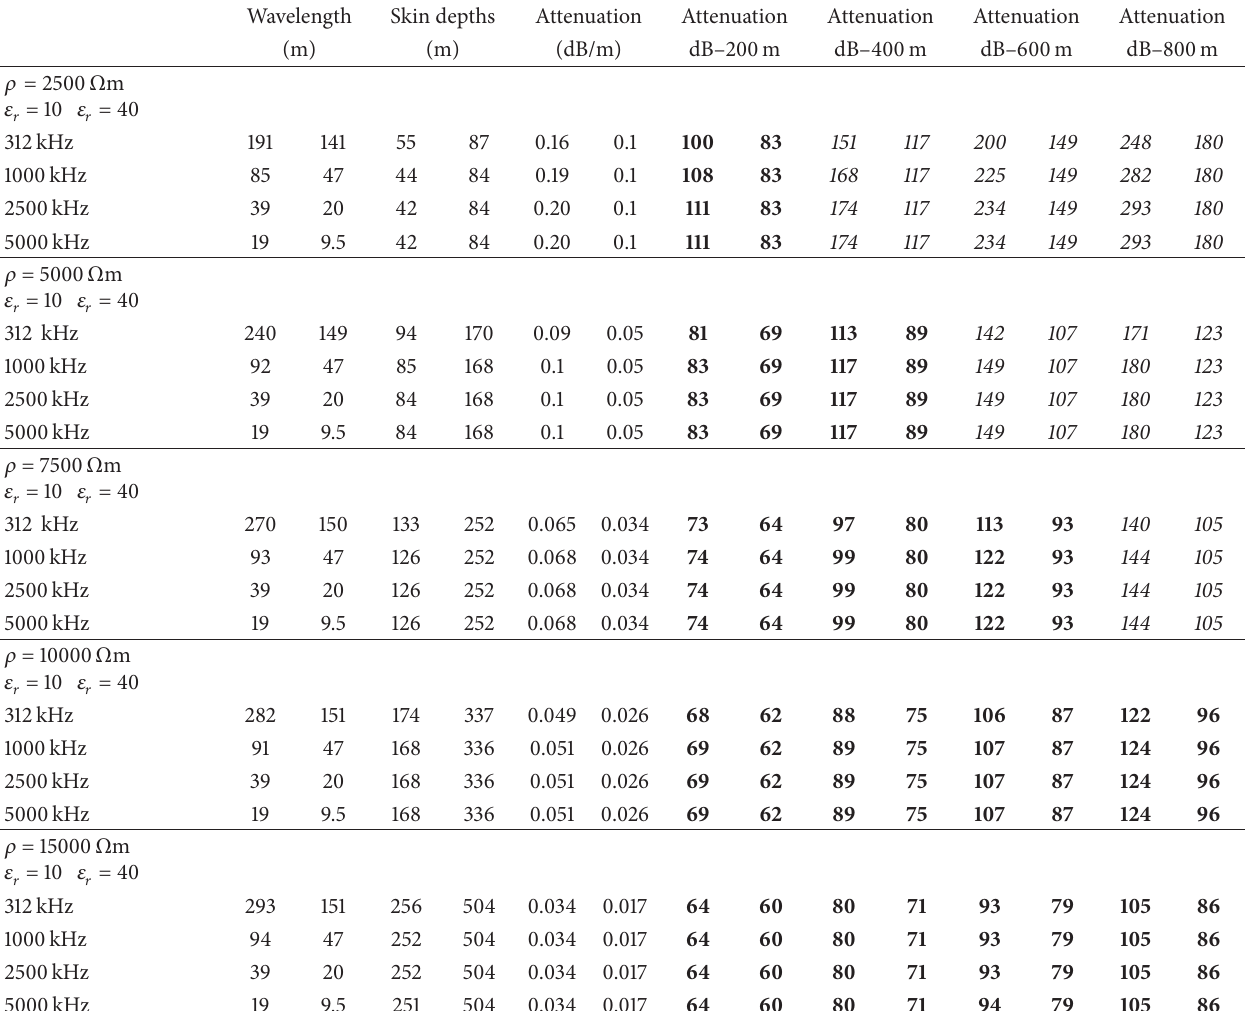
Table 2: The total attenuation losses (dB) as a function of material parameters and frequency. All other losses (e.g., in the device, different polarizations in transmission, and reception) are